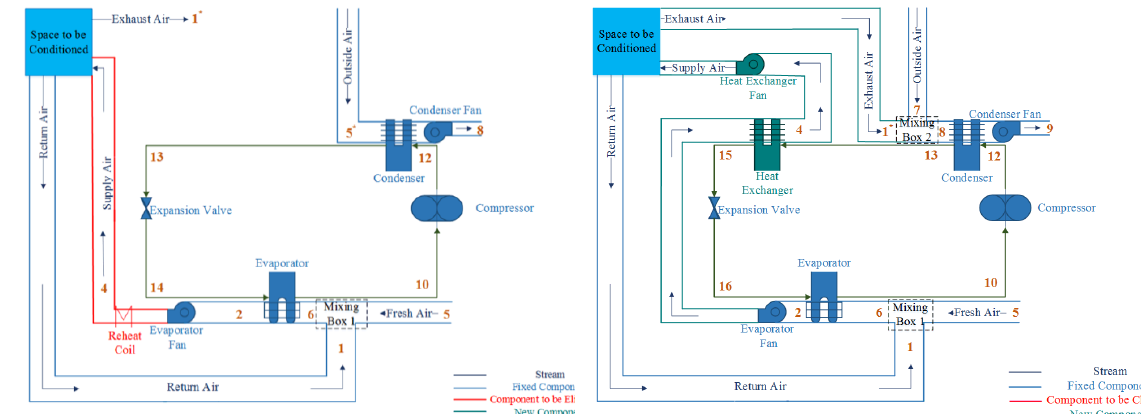
Figure 1. Conventional and integrated system structure Modeling